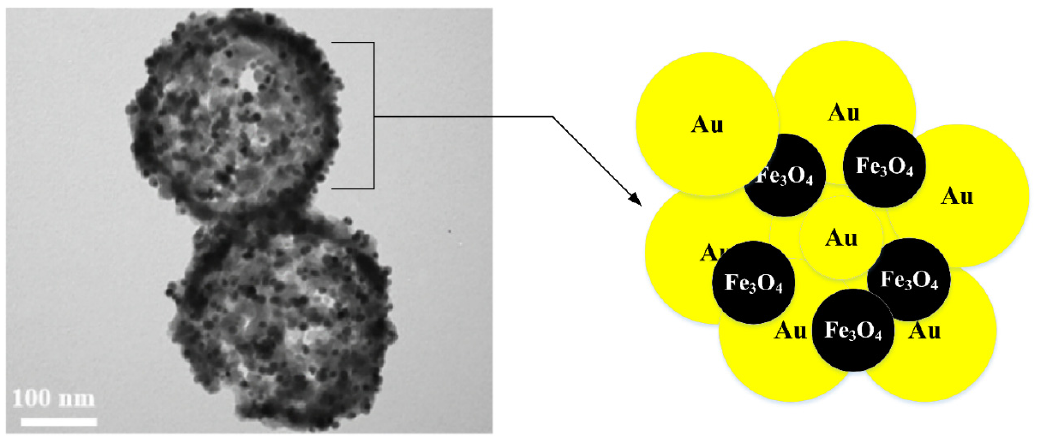
Figure 2. TEM image [39] and schematic illustration for the production of hybrid Fe 3 O 4 @Au